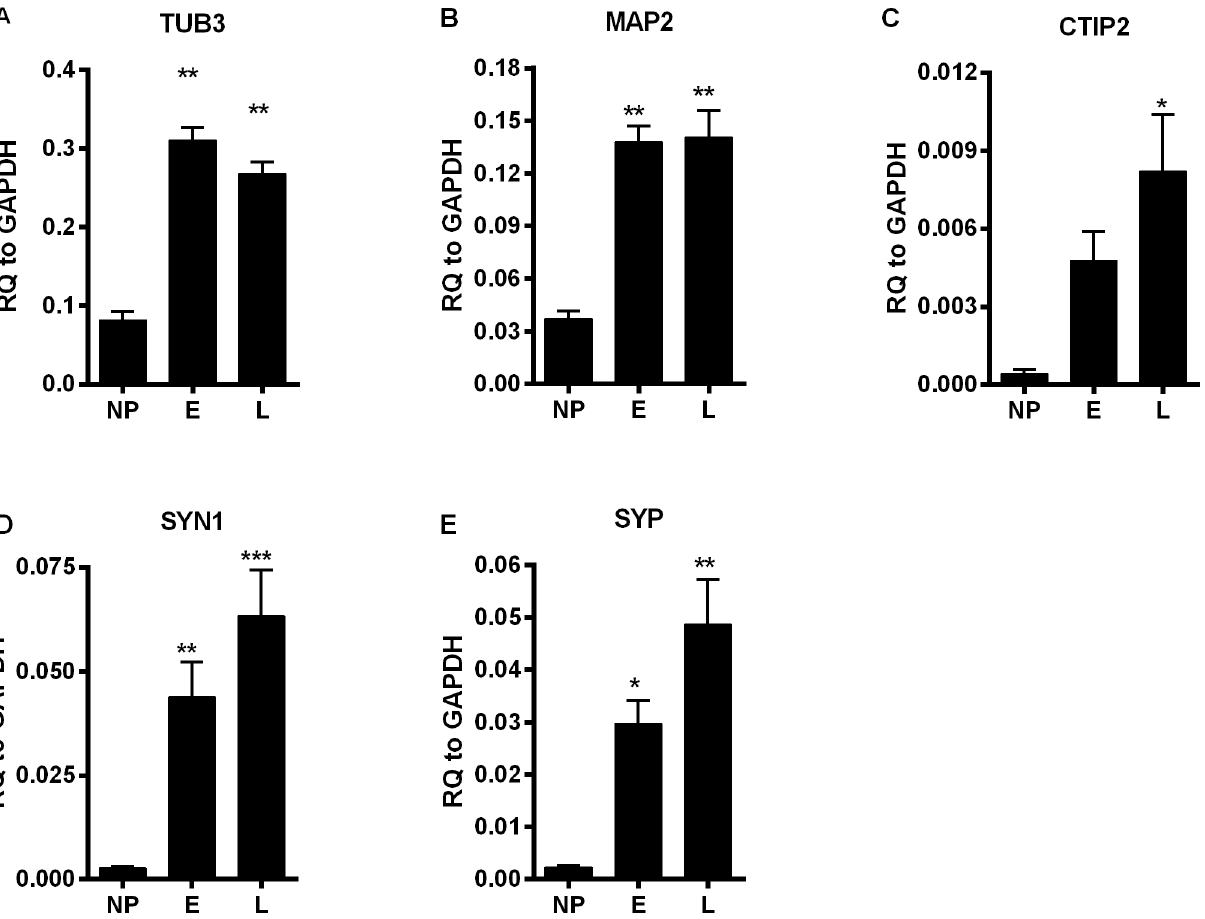
Fig 3. Quantitative RT-PCR of RNA samples from NPs and neurons. RNA samples were collected from NPs, E and L neurons and markers of neuronal gene expression were evaluated. Pan-neuronal markers, (A,B), cortical neuronal marker (C), and synaptic markers (D,E) were evaluated. Each bar represents mean ± standard error (n = 8, combining 4 BPD and 4 controls). One-way ANOVA was performed and Bonferroni ’ s Multiple Comparison post-hoc test was done. * p < 0.01, ** p < 0.001, *** p < 0.0001 compared to NP.